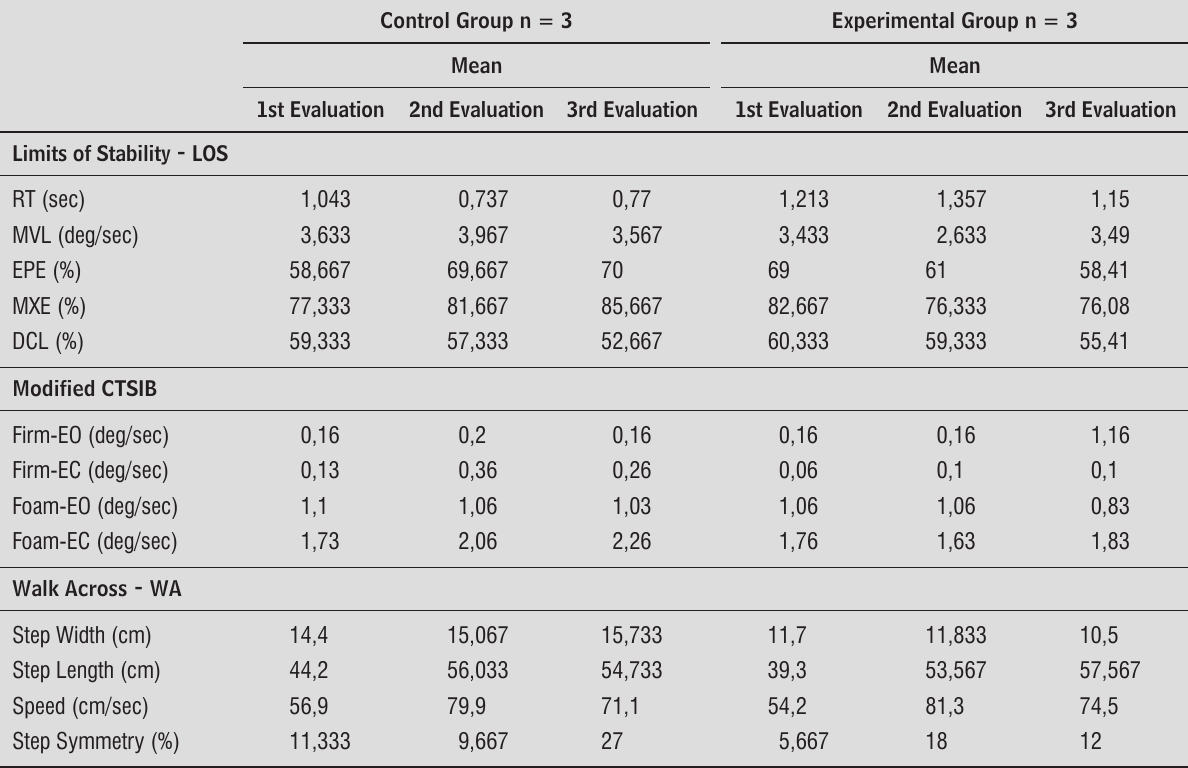
Table 3 - Baropodometric Variables in the Pre-frail and Frail